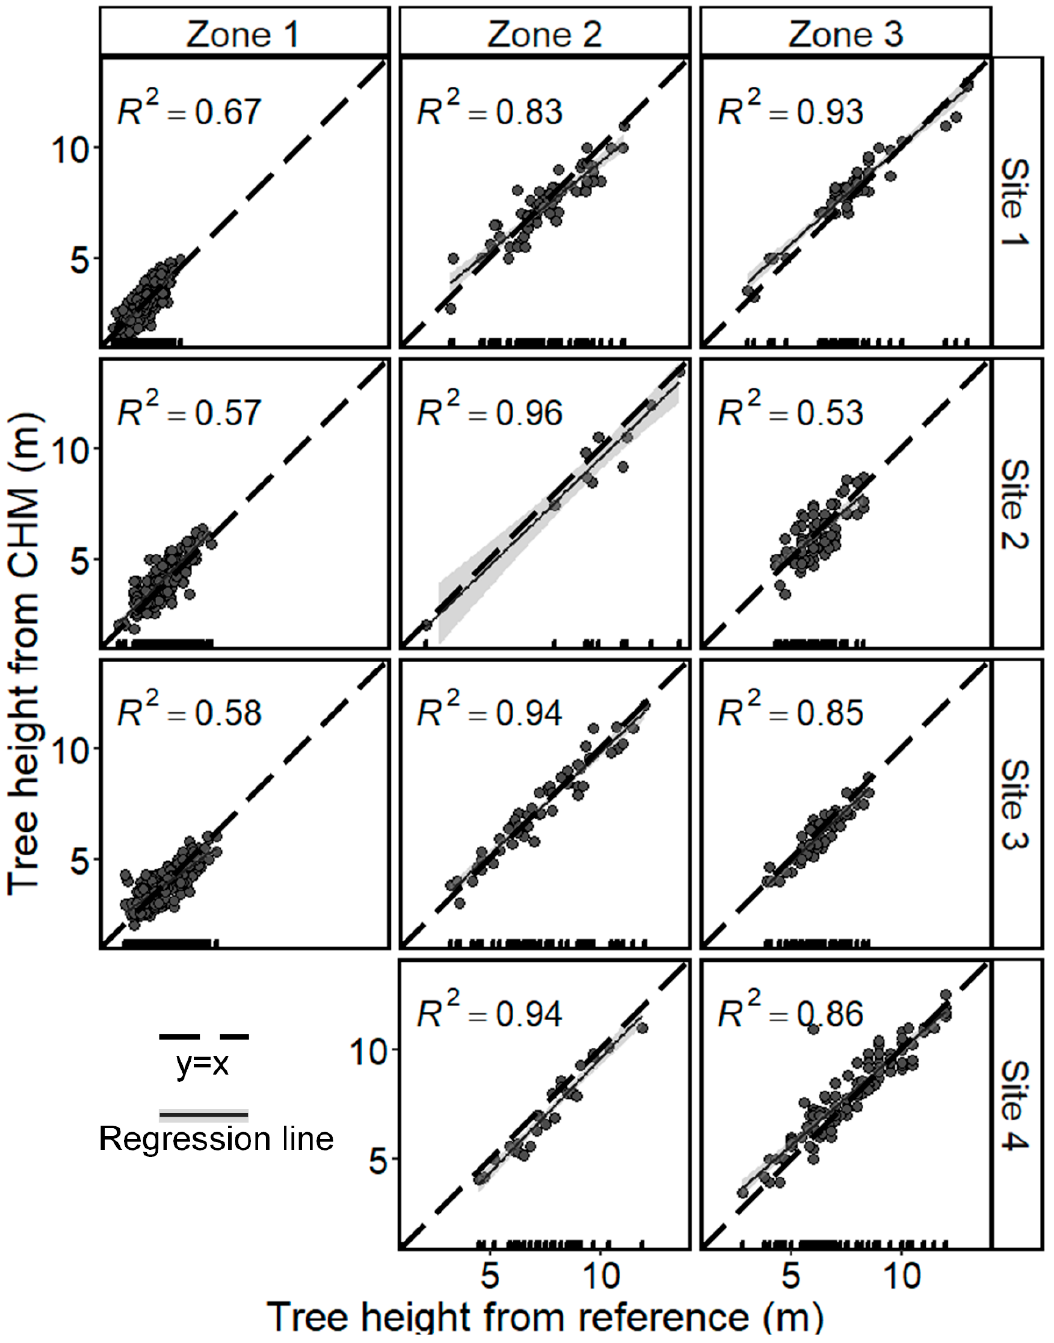
Figure A2. Site-specific comparison of H from CHM with actual measured values (reference values) in trees with coppice stand form.